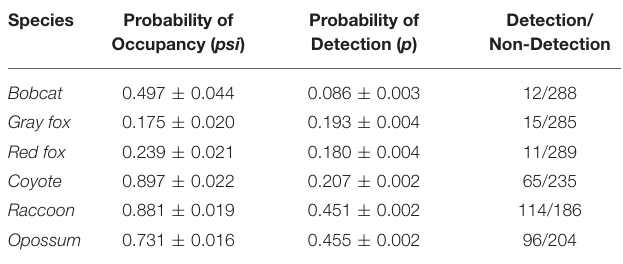
TABLE 1 | Probability of occupancy and detection, and the number of detections/non-detections by species. Species Probability of Occupancy ( psi )